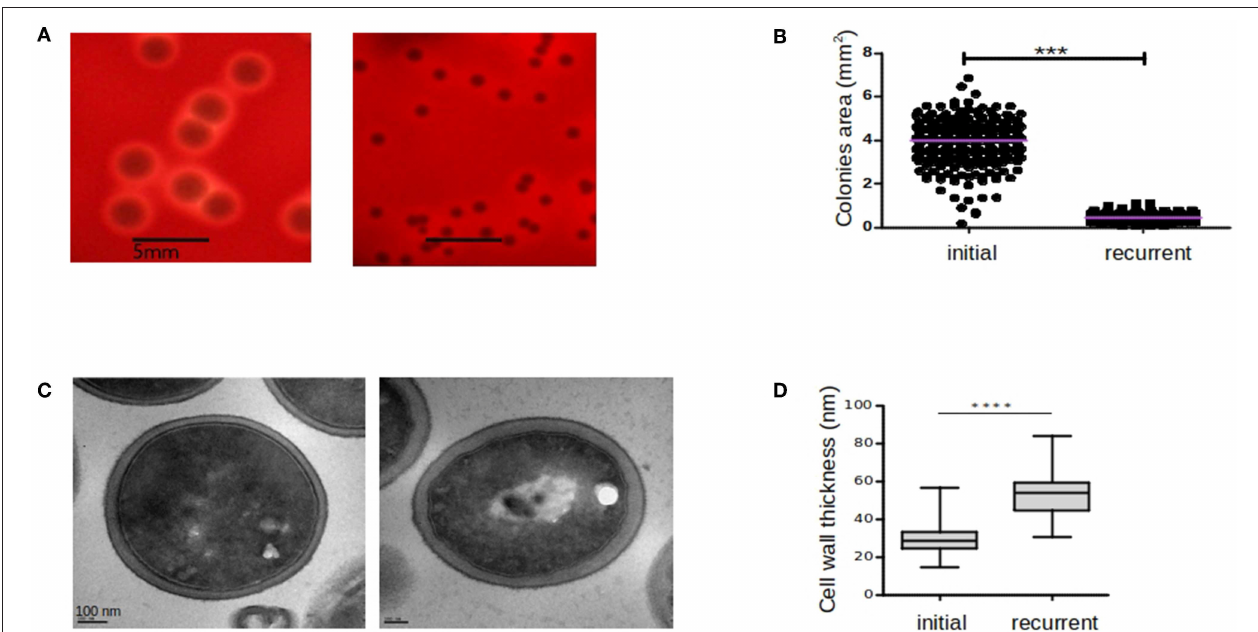
FIGURE 2 | Comparison of colony sizes, hemolytic activities, and cell wall thickness between initial and recurrent infections. The initial-WT (ST20130944) and recurrent-SCV (ST20130945) strains were cultured on blood agar plates and hemolytic activity (A) and colony areas (B) were assessed after 48 h incubation at 37 ◦ C. Cell-wall thickness of ST20130944 (left hand-side) and ST20130945 (right hand-side) strain photographed by TEM (C) and comparison of cell-wall thickness of initial and recurrent strains (D) . Colony areas (mm 2 ) were measured among three independent experiments and compared using the non-parametric exact Wilcoxon-Mann-Whitney test with alpha < 0.05. Thickness measurements (mm) were taken twice per cell in 30 cells per condition and compared using the non-parametric exact Wilcoxon-Mann-Whitney test with alpha < 0.05. Horizontal bars denote the 1st, 2nd (median), and 3rd quartiles. *** p < 0.001 and **** p < 0.0001.